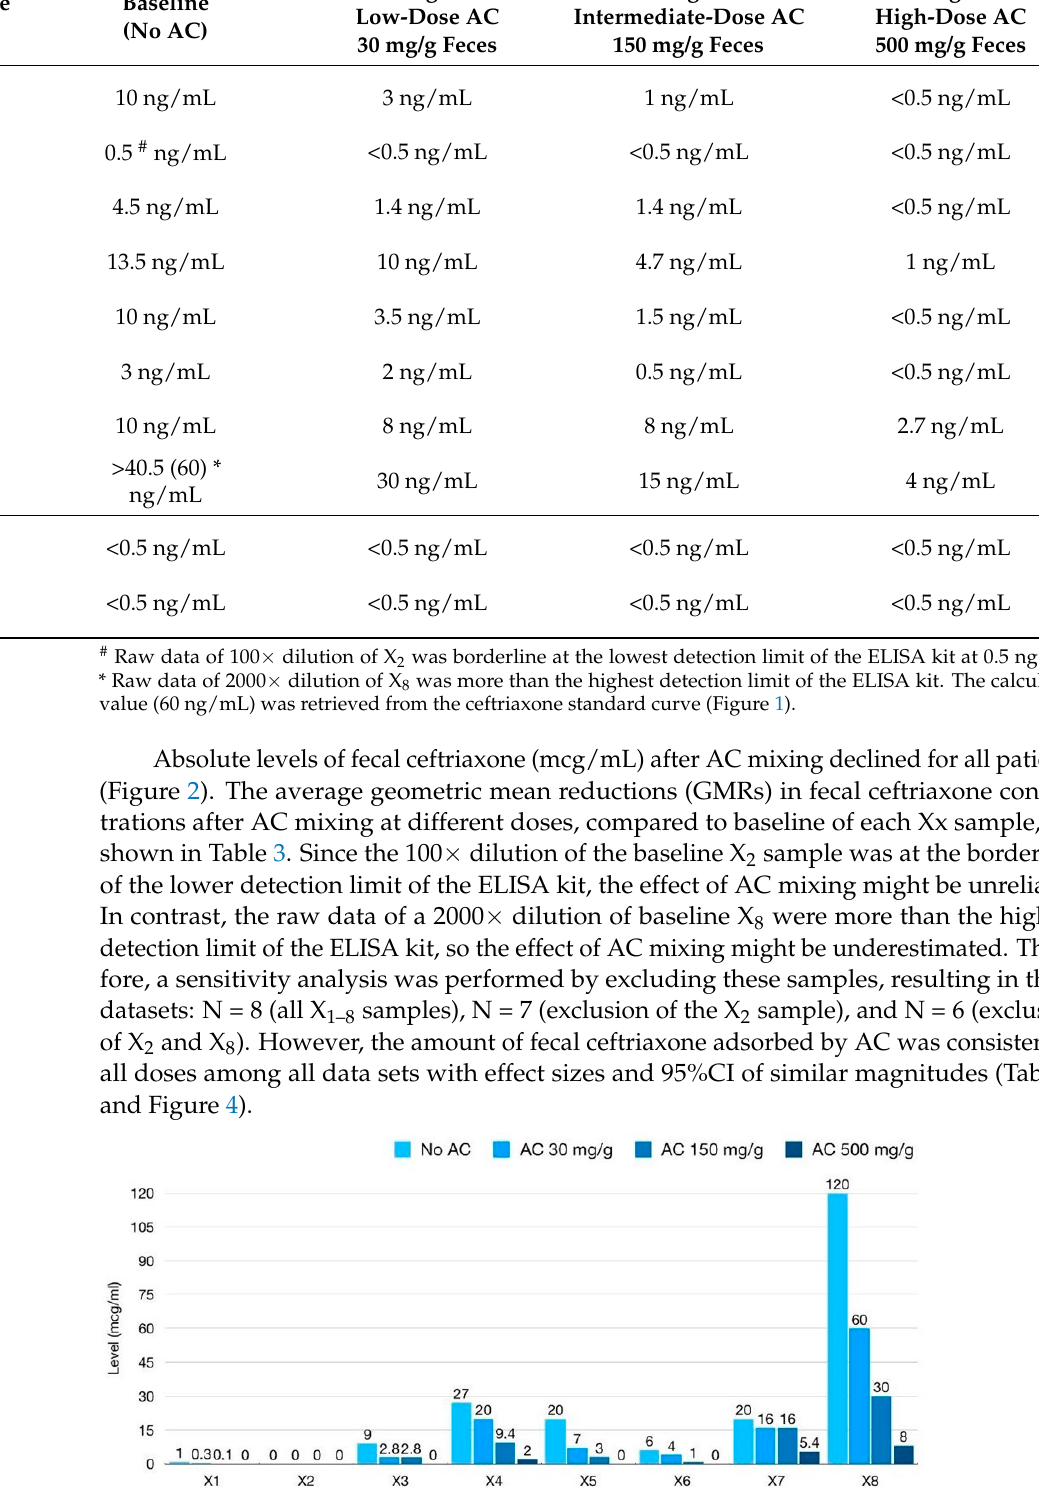
Figure 3. The association of fecal ceftriaxone levels (mcg/mL) and post-IV-ceftriaxone duration prior to fecal sample collection (hours) . Table 3. Geometric mean reduction (GMR), 95%CI and p -value, and % adsorption by activated char- coal (AC) at low dose 30 mg/g feces, intermediate dose 150 mg/g feces, and high dose 500 mg/g feces. Dataset 1; N = 8 (All X 1–8 ) Low dose AC